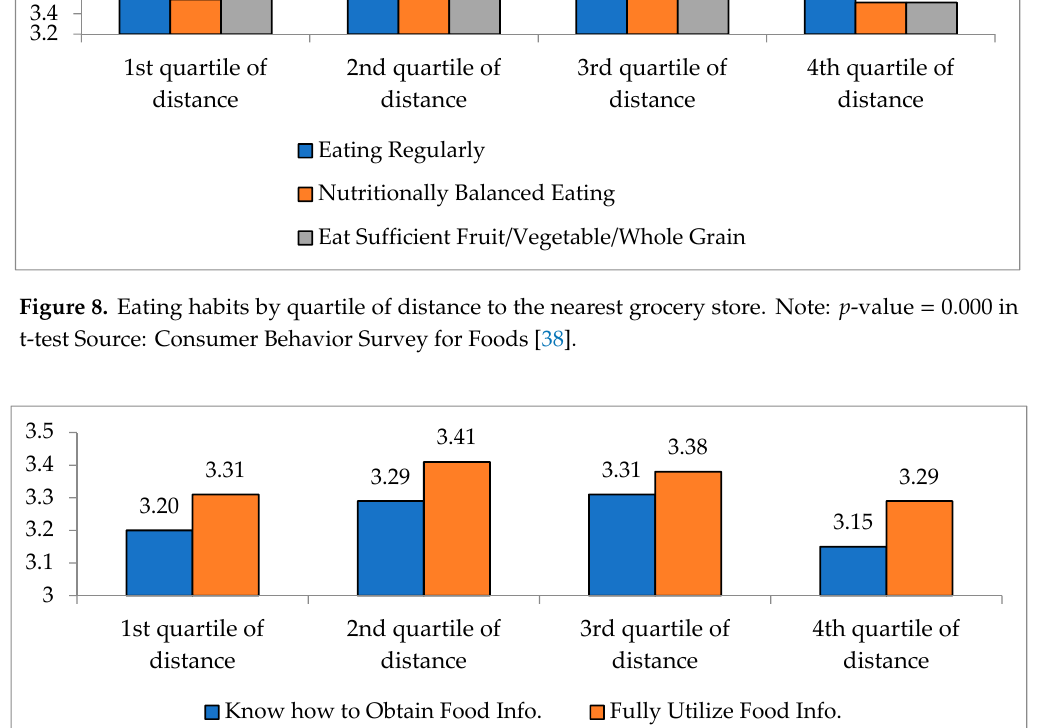
Figure 9. Acquisition and utilization of food-related information by quartile of distance to the nearest grocery store. Note: p -value = 0.000 in t-test Source: Consumer Behavior Survey for Foods [38].